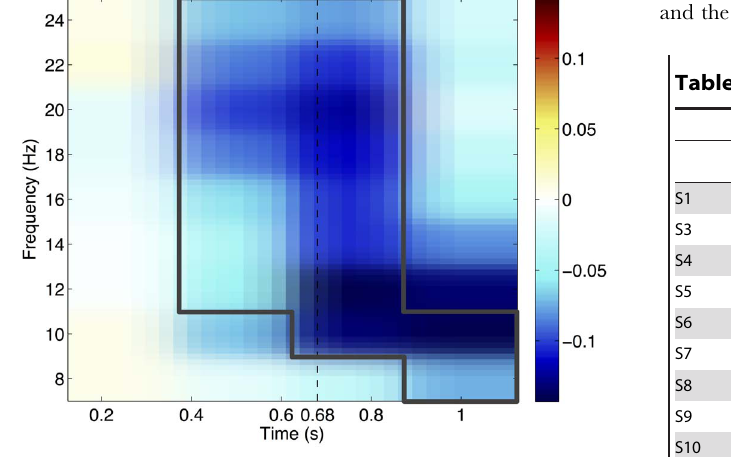
Figure 5. Grand Average TFR. Grand average TFR results for the training block for channel C3. The data shown here is a normalised difference between the related and unrelated conditions, obtained by related { unrelated . The grey box indicates in which parts of the figure the related z unrelated difference between the two conditions is significant. The vertical dashed line indicates the grand average reaction time, i.e., when the subjects pressed the button.